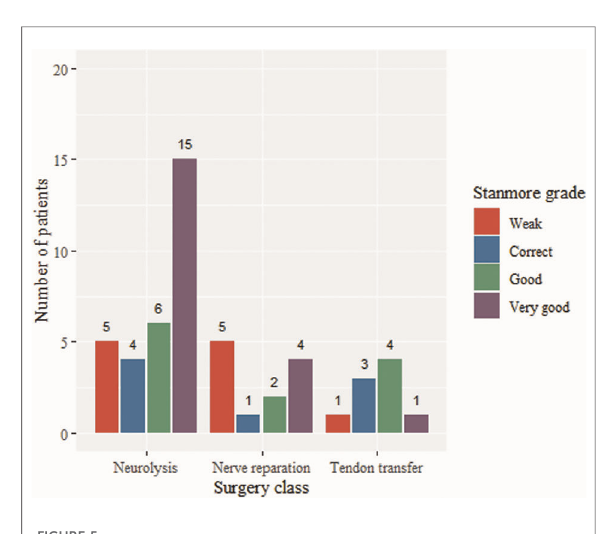
FIGURE 4 Stanmore scores among different surgical treatment modalities.